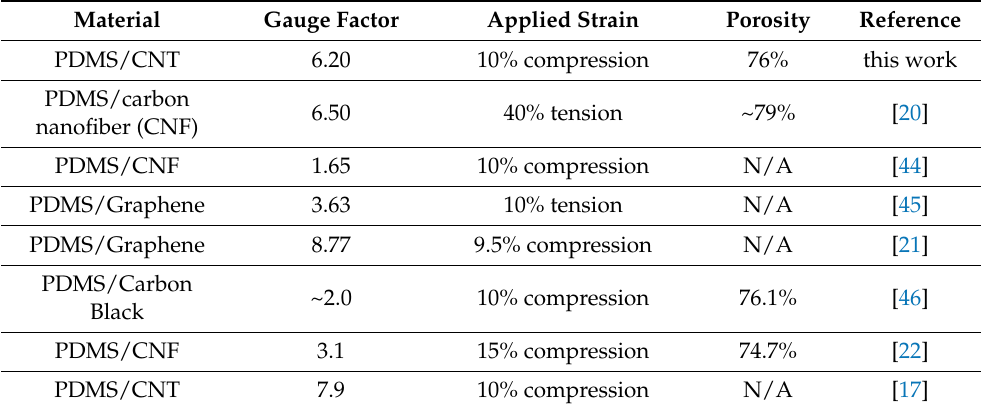
Table 2. Comparison of gauge factor of the reported nanocomposite sensor with published sensor data in the